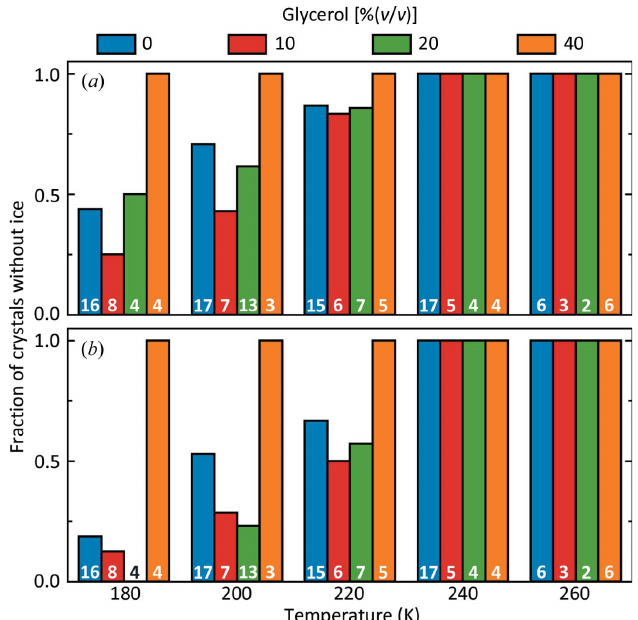
Figure 3 The fraction of apoferritin crystals at each temperature and glycerol concentration that remained free from ice diffraction for at least ( a ) 3 s and ( b ) 20 s after the unit cell reached its steady state or minimum value, excluding the (cid:2) 25% of crystals that formed hexagonal ice in external solvent. The numbers on each bar indicate the crystals examined for each condition. Data for thaumatin are given in Supplementary Fig. S7.